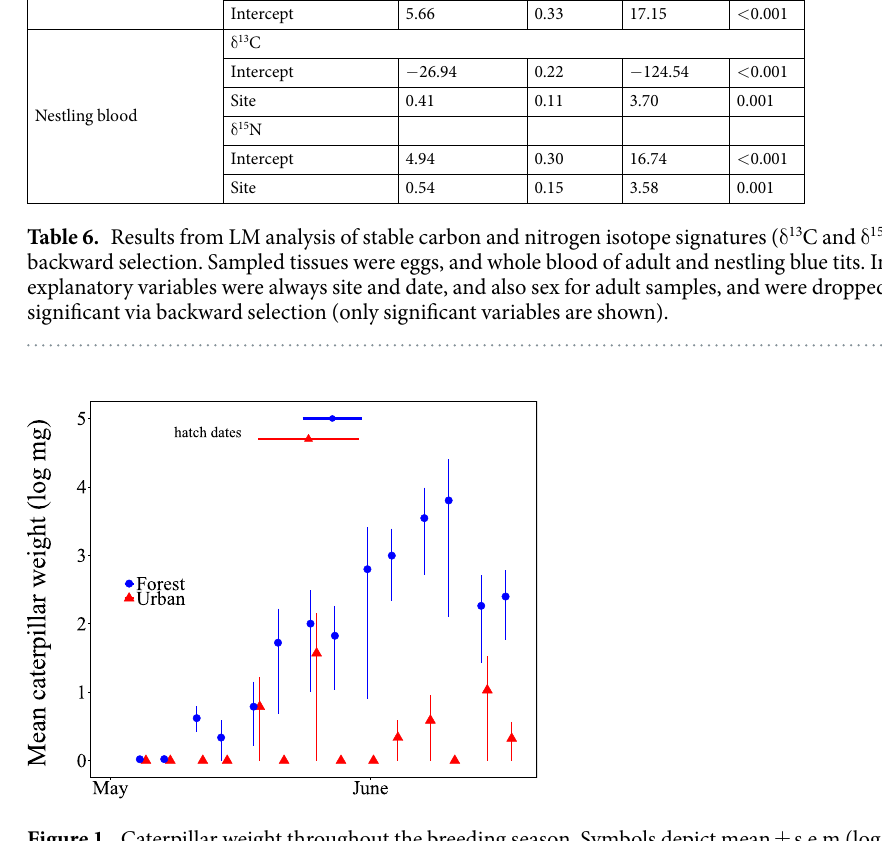
Figure 1. Caterpillar weight throughout the breeding season. Symbols depict mean ± s.e.m (log transformed) of dry weight of all caterpillars sampled from five different trees at each time point at each site; site is depicted by red (urban) or blue (forest) colours. Horizontal red and blue dashed lines represent hatch dates (mean ± s.e.m) for broods in the urban and forest site,